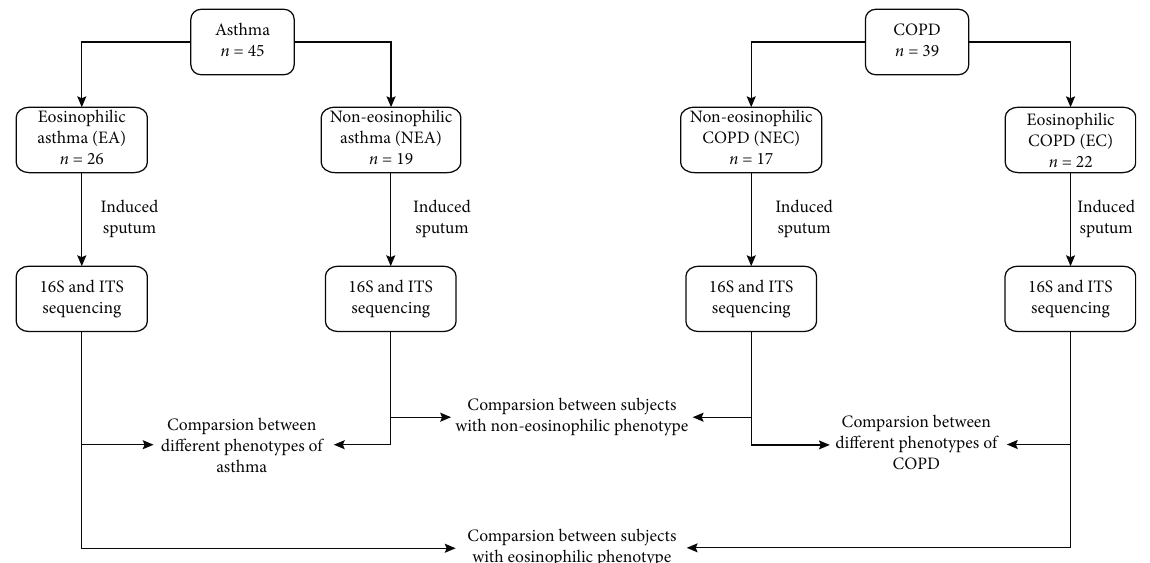
Figure 1: The study fl